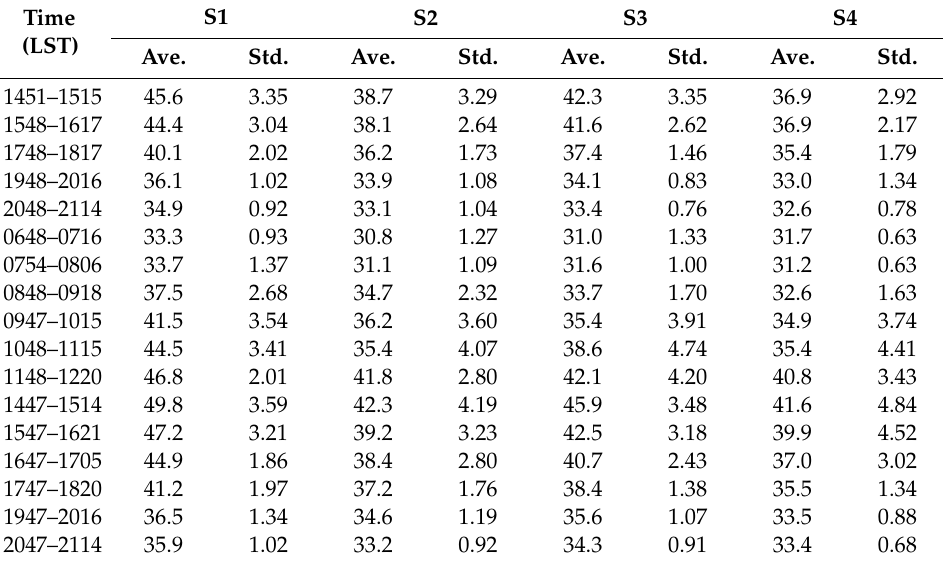
Table 5. The same as in Table 4 except for road surface temperatures